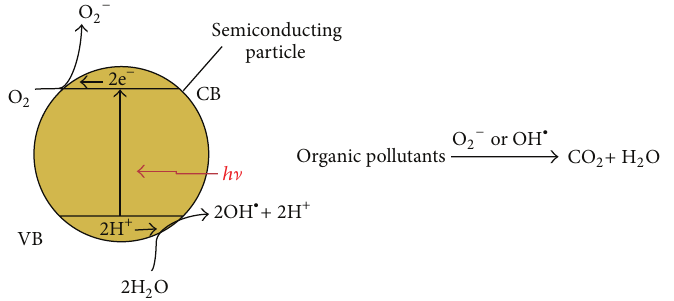
Figure 2: Schematic illustration of the UV-induced degradation of organic pollutants by semiconductors [9].